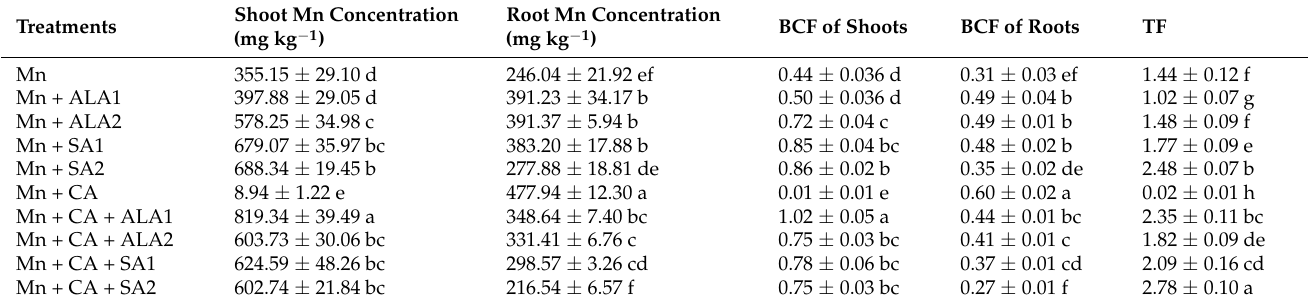
Table 3. Effects of 5-aminolevulinic acid or salicylic acid (ALA/SA) combined with citric acid (CA) on manganese (Mn) concentration, bioconcentration factor (BCF), translocation factor (TF) in sunflower under Mn